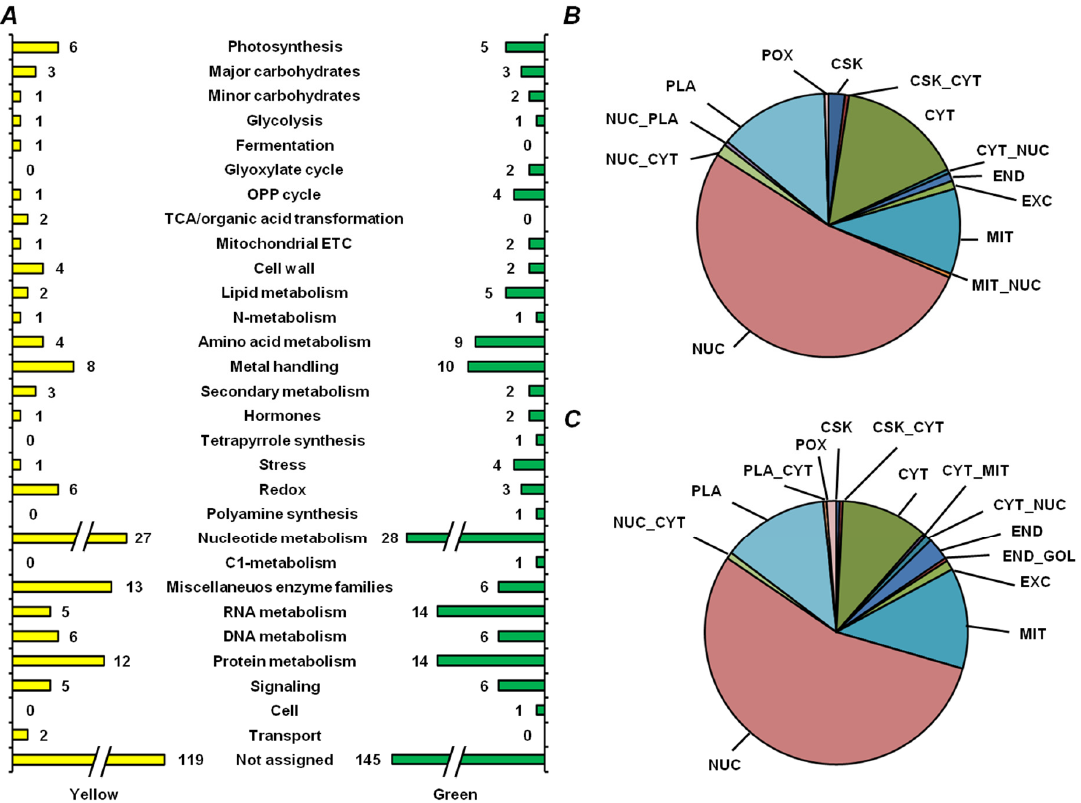
Figure 7. Functional annotation ( A ) and prediction of subcellular localization ( B , C ) of proteins, unique for yellow seeds of cultivar Millennium (yellow color in panel A and C ) and for green seeds of cultivar Gloriosa (green color in panel A and B ), both in nondepleted samples and after treatment with 0.07% ( w/v ) protamine sulfate. Subcellular fractions: CSK, cytoskeleton; CYT, cytoplasm; END, endoplasmic reticulum; EXC, extracellular/secreted; GOL, Golgi apparatus; MIT, mitochondria; NUC, nuclear; PLA, plasma membrane; POX, peroxisome; doubled labels denote corresponding combinations of possible localization.